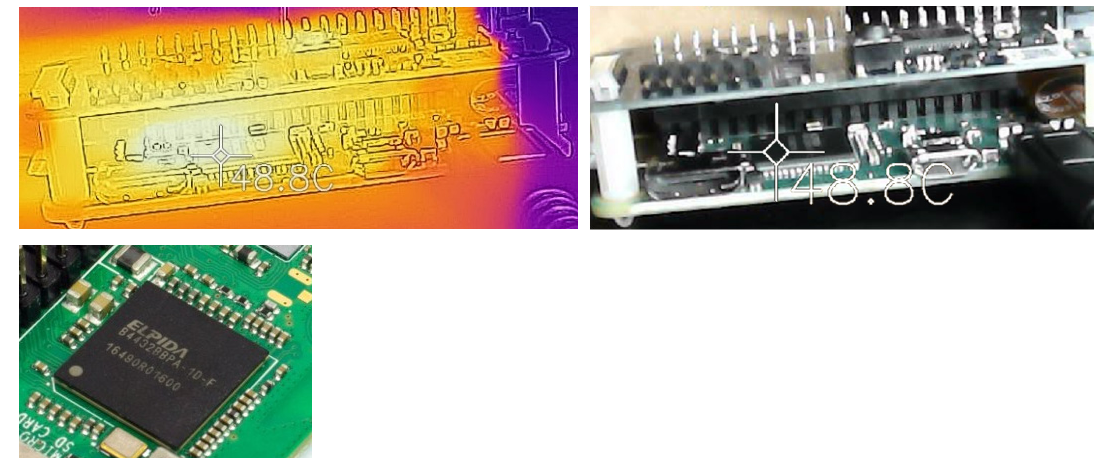
Figure 12. Temperature at the SoC of the IoT node executing the CNN. Third, at the level of power consumption, the execution of the CNN was tested using a precision multimeter. Figure 13 depicts the level of intensity required by the IoT platform when the CNN begins its execution. The solar cell installed in the remote location where the node is working has been dimensioned according to the IoT power consumption. Fourth, at the level of resources, the application that runs the CNN takes 16.4% of the CPU capacity and 8.7% of RAM. These results let us conclude that the available computing resources are adequate for running this sort of